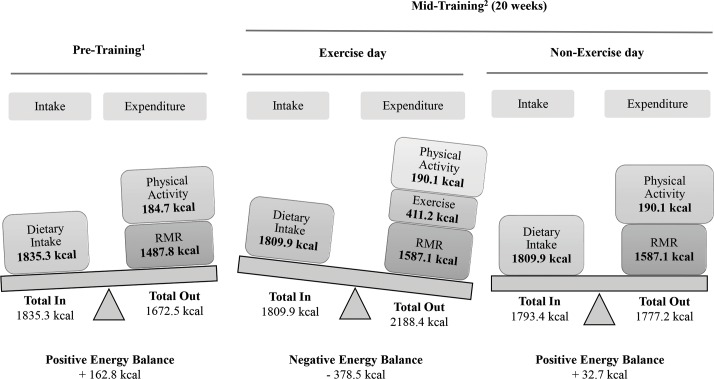
Changes in daily energy balance in the control and experimental groups at pre- and mid-training.RMR, resting metabolic rate; 1mean values for all groups; 2mean values for training and training-detraining groups.